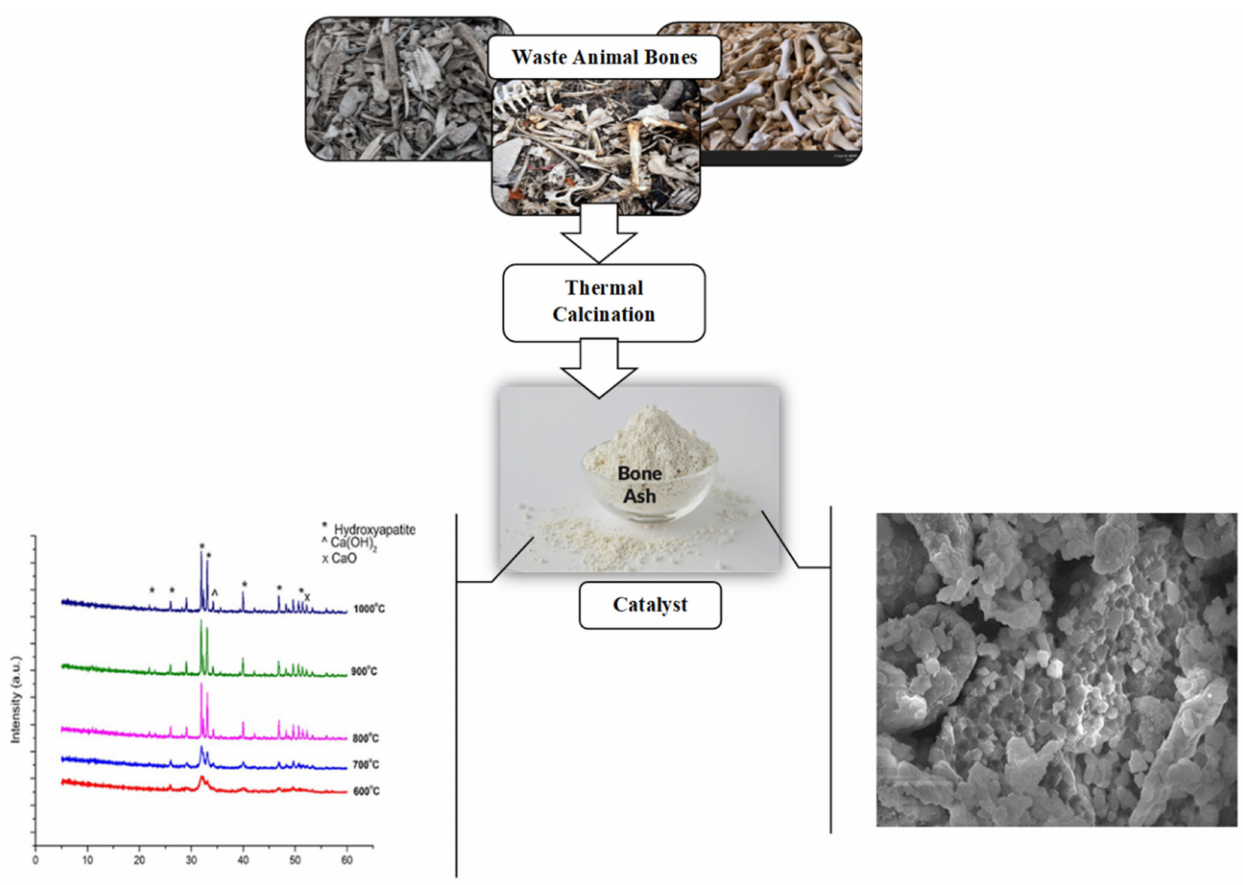
Figure 2. Conversion of waste animal bones into